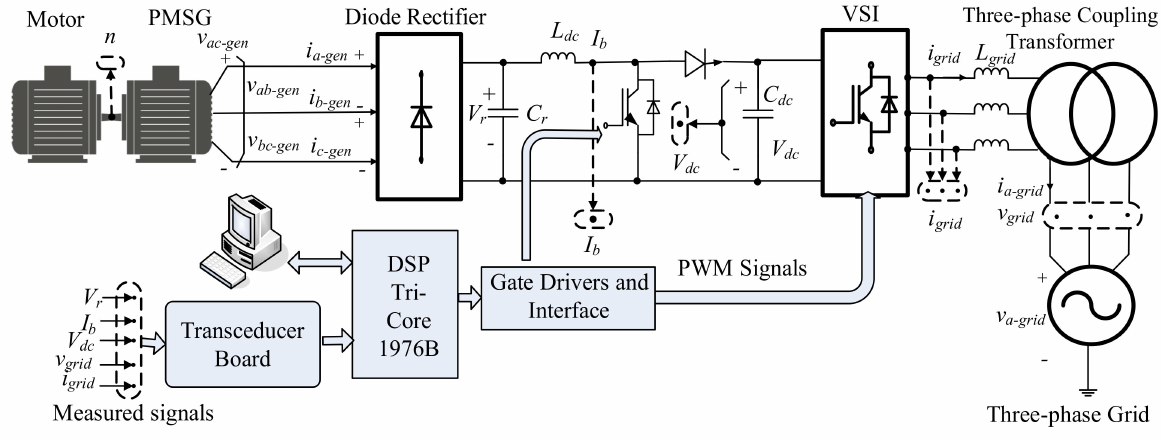
Figure 11. Block diagram of experimental set-up.